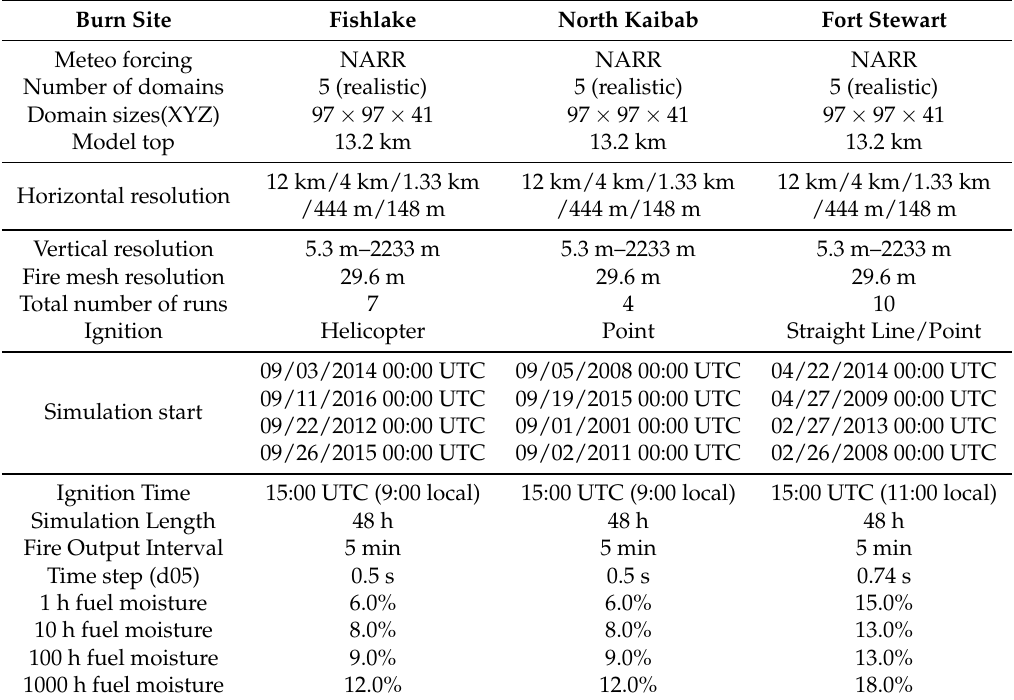
Table 1. Parameters of the experimental burn